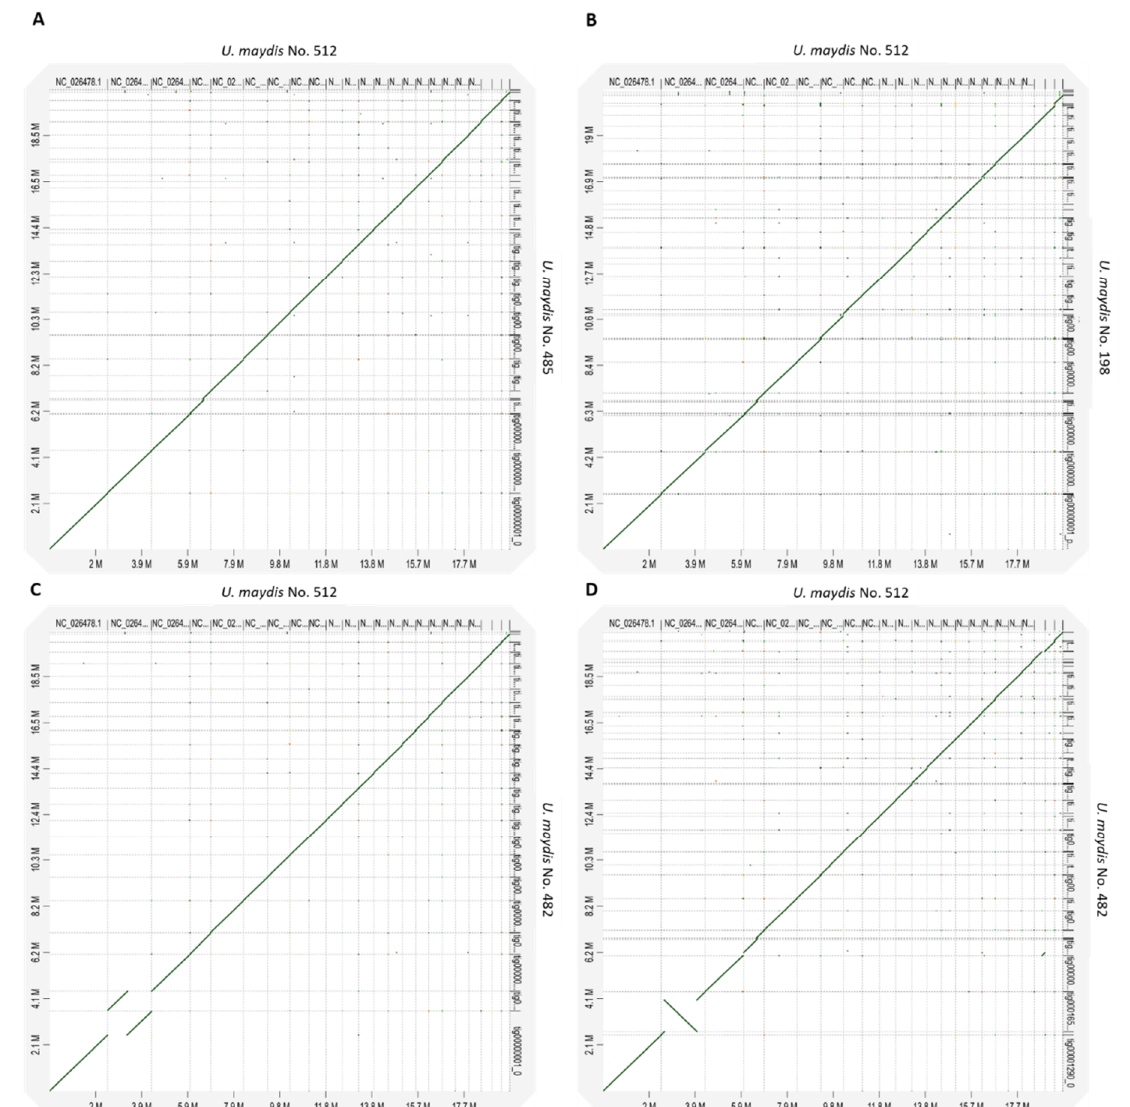
Figure 9. Whole genome macro synteny plot between the different U. maydis isolates compared to U. maydis No. 512. ( A ): U. maydis No. 485 and ( B ): U. maydis No. 198. ( C , D ): Two isolates were sequenced in case of U. maydis No. 482 and therefore are visualized separately.